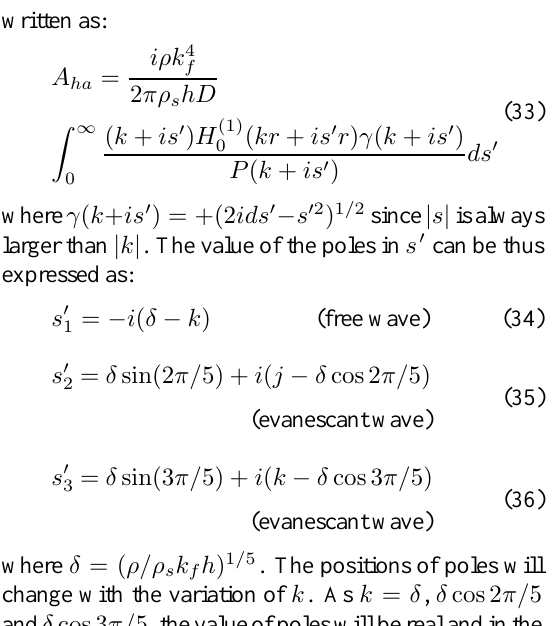
Fig. 5. Vertical force transmission at mount 1-infinite plate with light fluid loading under the unit moment excitation around z-axis at c.g. of rigid body. The isolator stiffness in all directions is enlarged 100 times as compared with that in Fig.